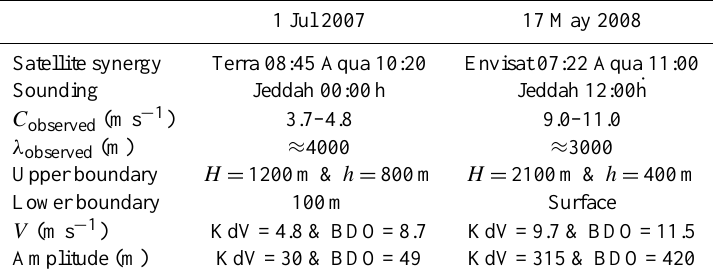
Table 2. Weakly nonlinear long wave analysis for the two case studies presented in the end of Sect. 2 (1 July 2007 and 17 May 2008). All times are in UTC. The upper boundaries are listed using “ H ” for KdV and “ h ” for BDO, and they represent the levels where 8 = 0 and 8 z = 0, respectively. See text for more